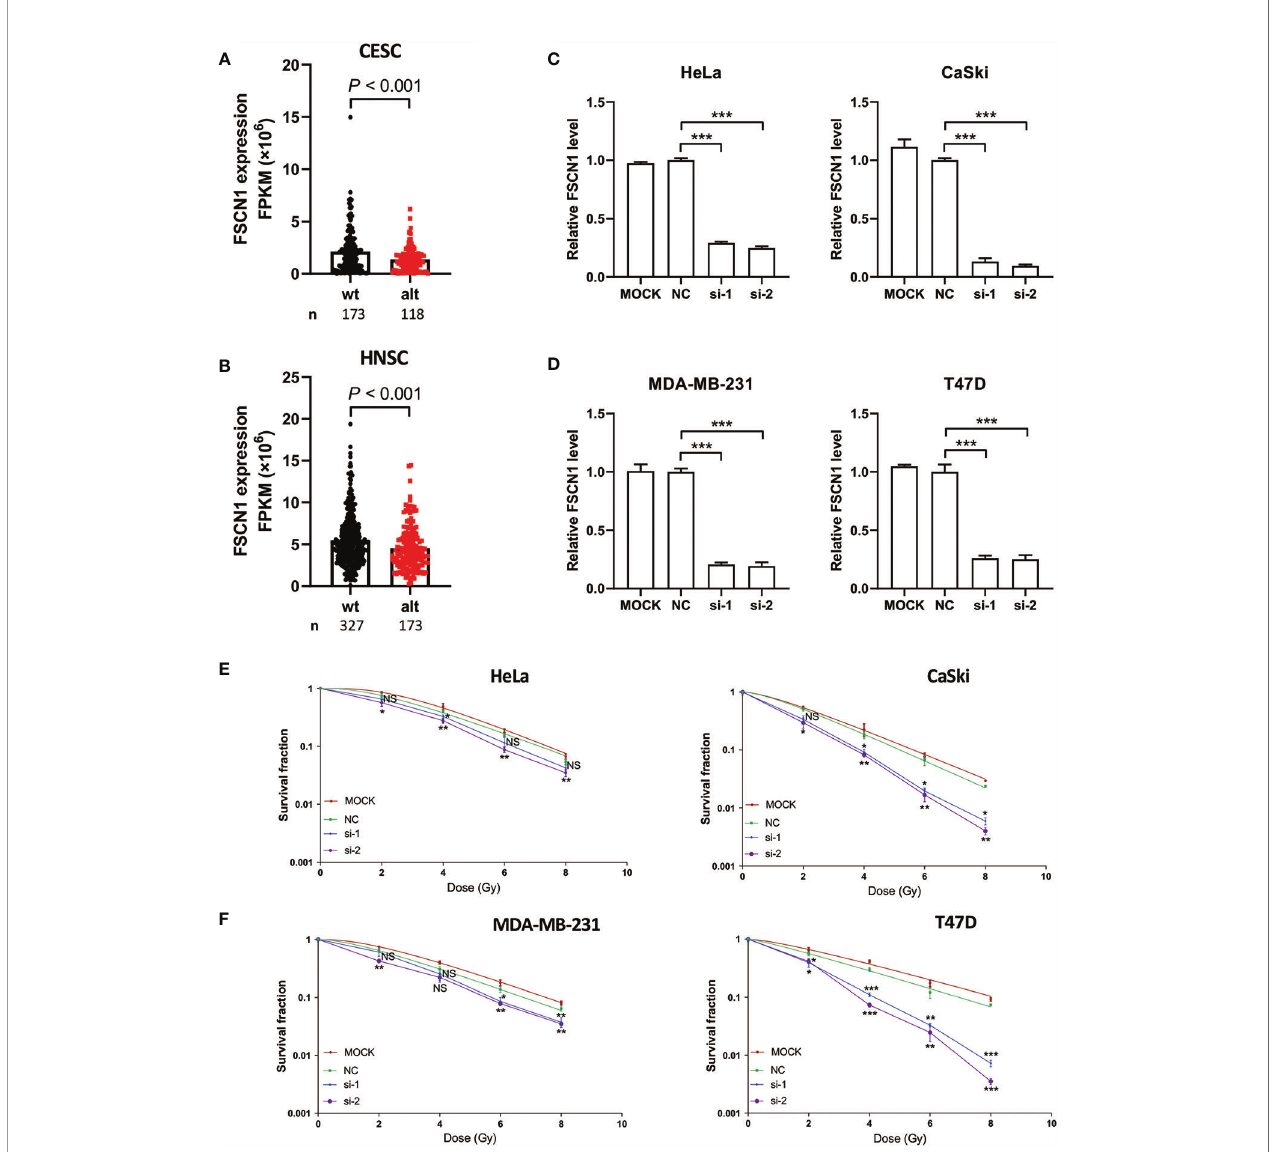
FIGURE 2 | FSCN1 silencing enhances sensitivity of cancer cells with PIK3CA alterations to IR treatment. (A, B) The expression of FSCN1 in PIK3CA-altered and PIK3CA-wild-type patients from the GEPIA database. (C, D) The knockdown ef fi ciency of siFSCN1s. Relative expression of FSCN1 in HeLa, CaSki, MDA-MB-231, and T47D cells was detected using qRT-PCR. (E, F) Knockdown of FSCN1 sensitizes cancer cells to IR treatment. Colony formation assays of HeLa, CaSki, MDA- MB-231, and T47D cells transfected with FSCN1 siRNA. Surviving fractions were determined based on plating ef fi ciencies. Plating ef fi ciency of Hela, Caski, T47D, MDA-MB-231 is 62.3, 54.16, 63, and 46.16%. Data are presented as the means±SEM of at least three independent experiments. * P < 0.05; ** P < 0.01; *** P < 0.001. NS, not signi fi